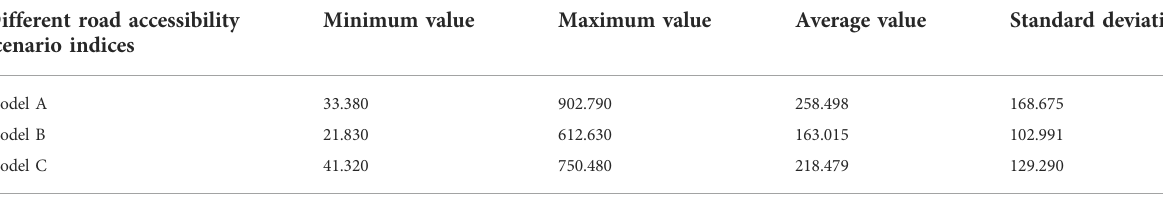
TABLE 2 Results of three road accessibility